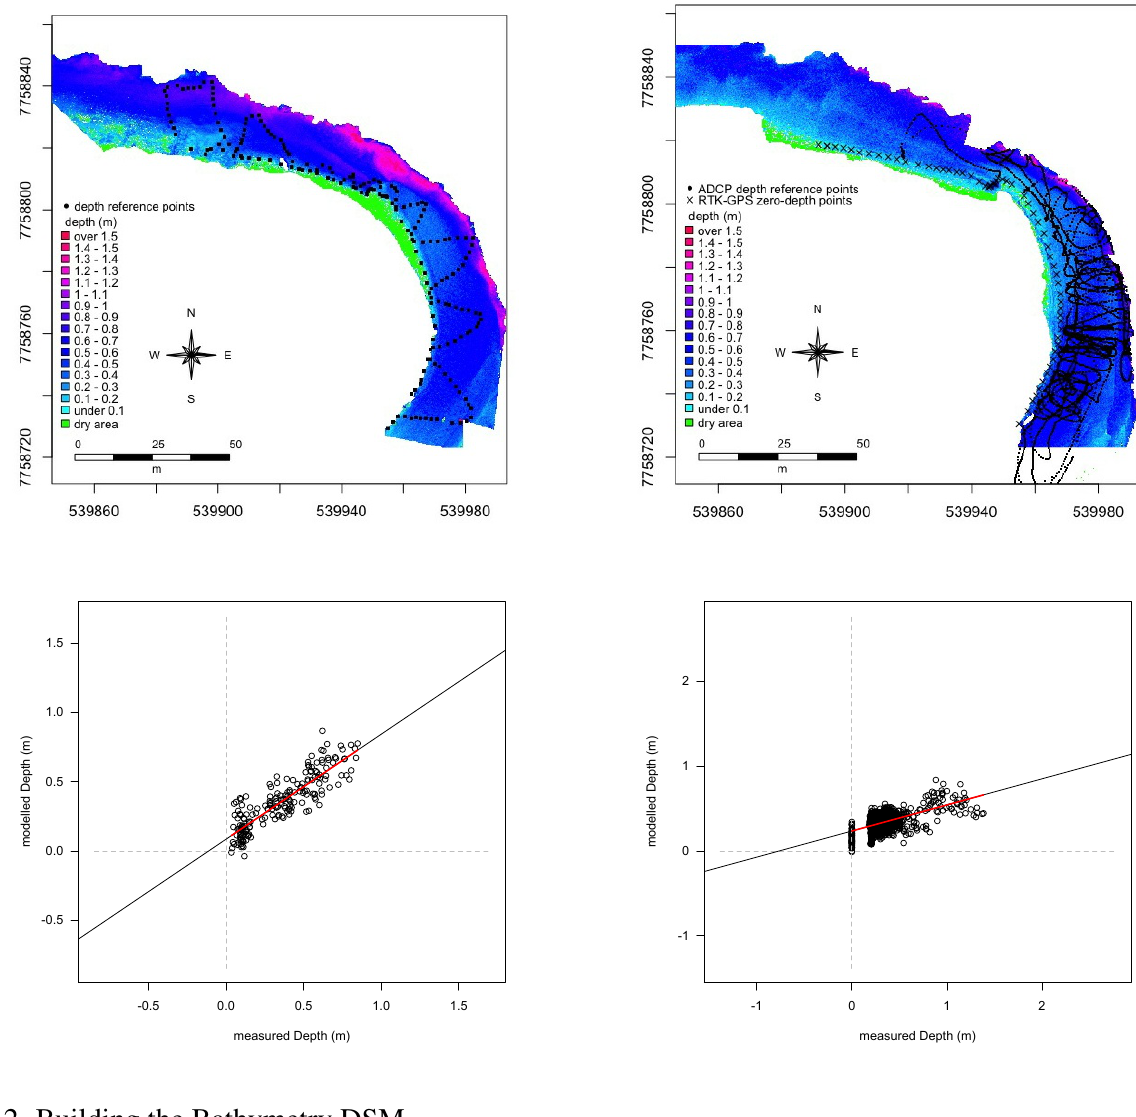
Figure 6. Bathymetric models of 2010 ( left ) and 2011 ( right ) using the Lyzenga model with calibrated L values. The plots show the modelled depths vs. the measured depths at the si ground data reference points. Green areas were modelled as dry ( i.e. , negative